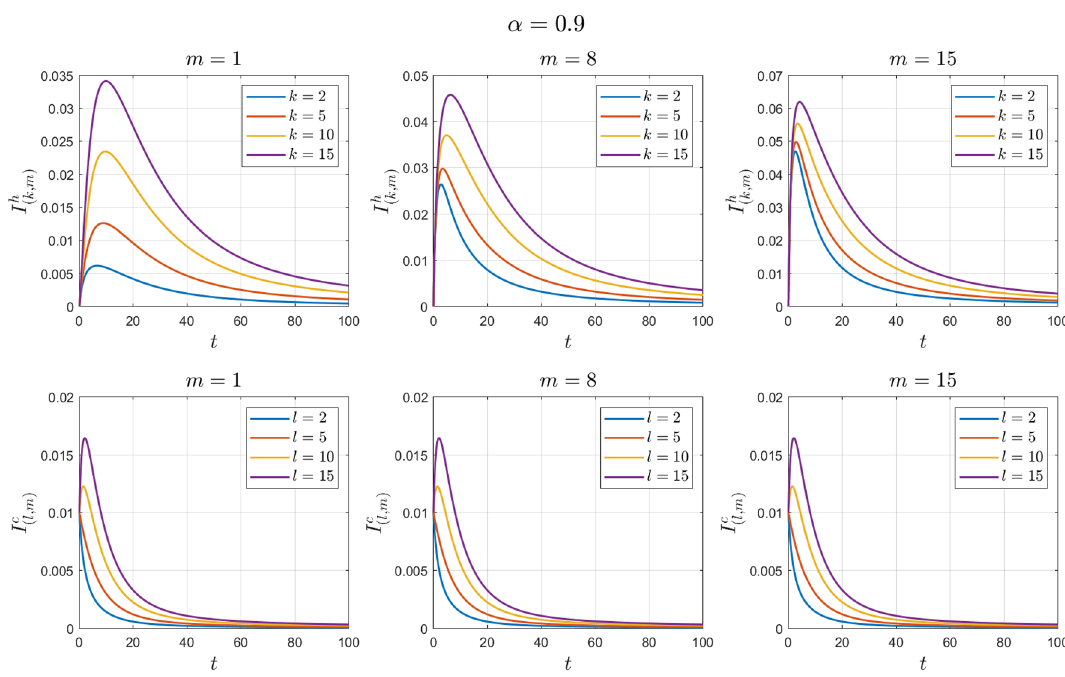
Figure 3. Numerical solutions of Example 1 for α = 0.9